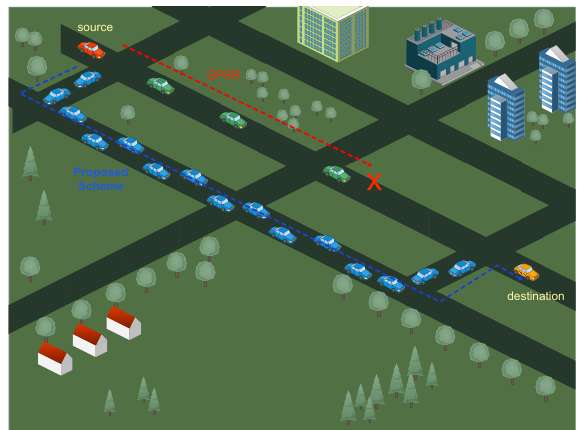
Figure 10. Example with various road-vehicle densities